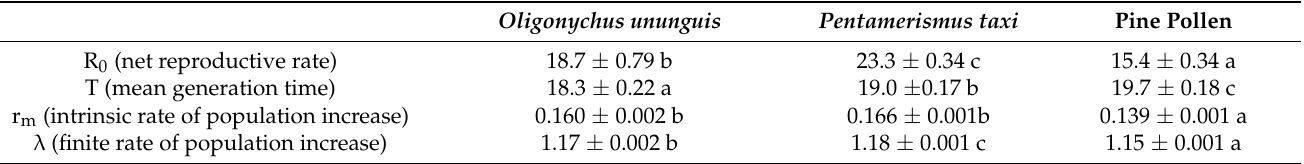
Table 3. Mean ( ± SE) life table parameters of Amblyseius andersoni reared on Oligonychus ununguis , Pentamerismus taxi or pine pollen. Values with different letters in a row differ significantly at p ≤